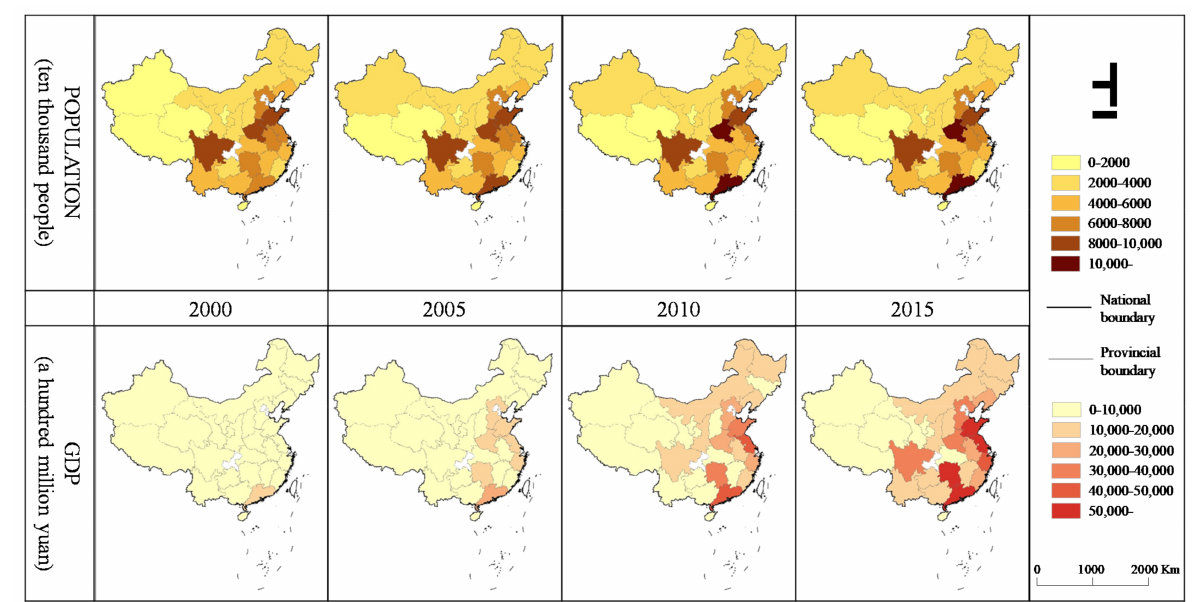
Figure 3. Spatial distribution of the GDP and population at the provincial scale.